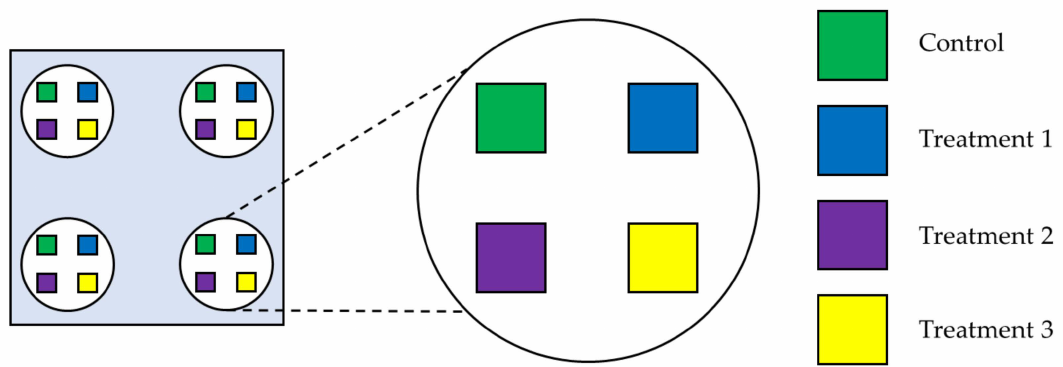
Figure 3. Schematic representation of how the moulds containing the beef meat were arranged in the oviposition deterrence trial. The grey square represents the cage seen from above; the green, blue, purple, and yellow squares represent the moulds containing the meat samples (one control and three different treatments); the white circles represent the supports to which the moulds are